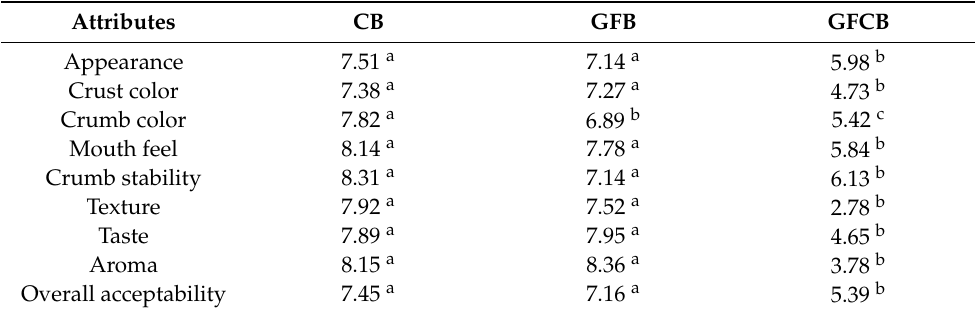
Table 6. Sensory evaluation of bread samples. Gluten Friendly™ bread (GFB), control bread (CB) and gluten-free commercial bread (GFCB) 1